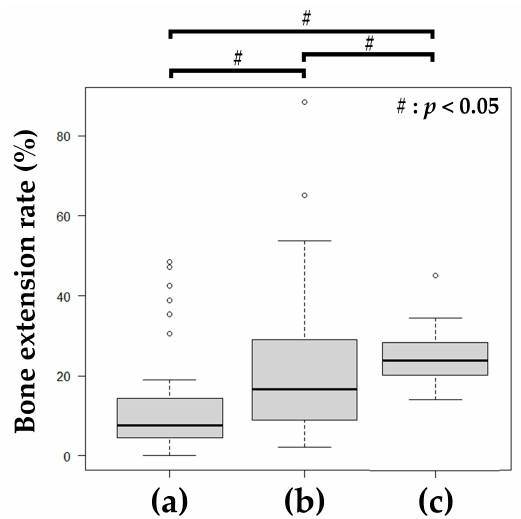
Figure 8. Tooled box graph of bone extension rates of ( a ) defects only, ( b ) BMP ( − ) constructs, and ( c ) BMP (+) constructs, determined by length-online measurements on soft X-ray images of rat cranial bone defects 8 weeks after the operation, respectively (n = 8 for BMP (+) constructs, n = 6 each for BMP ( − ) constructs and defects only). Note: Eight length-online measurements for each defect were performed. The statistics were carried out using the Kruskal–Wallis test.